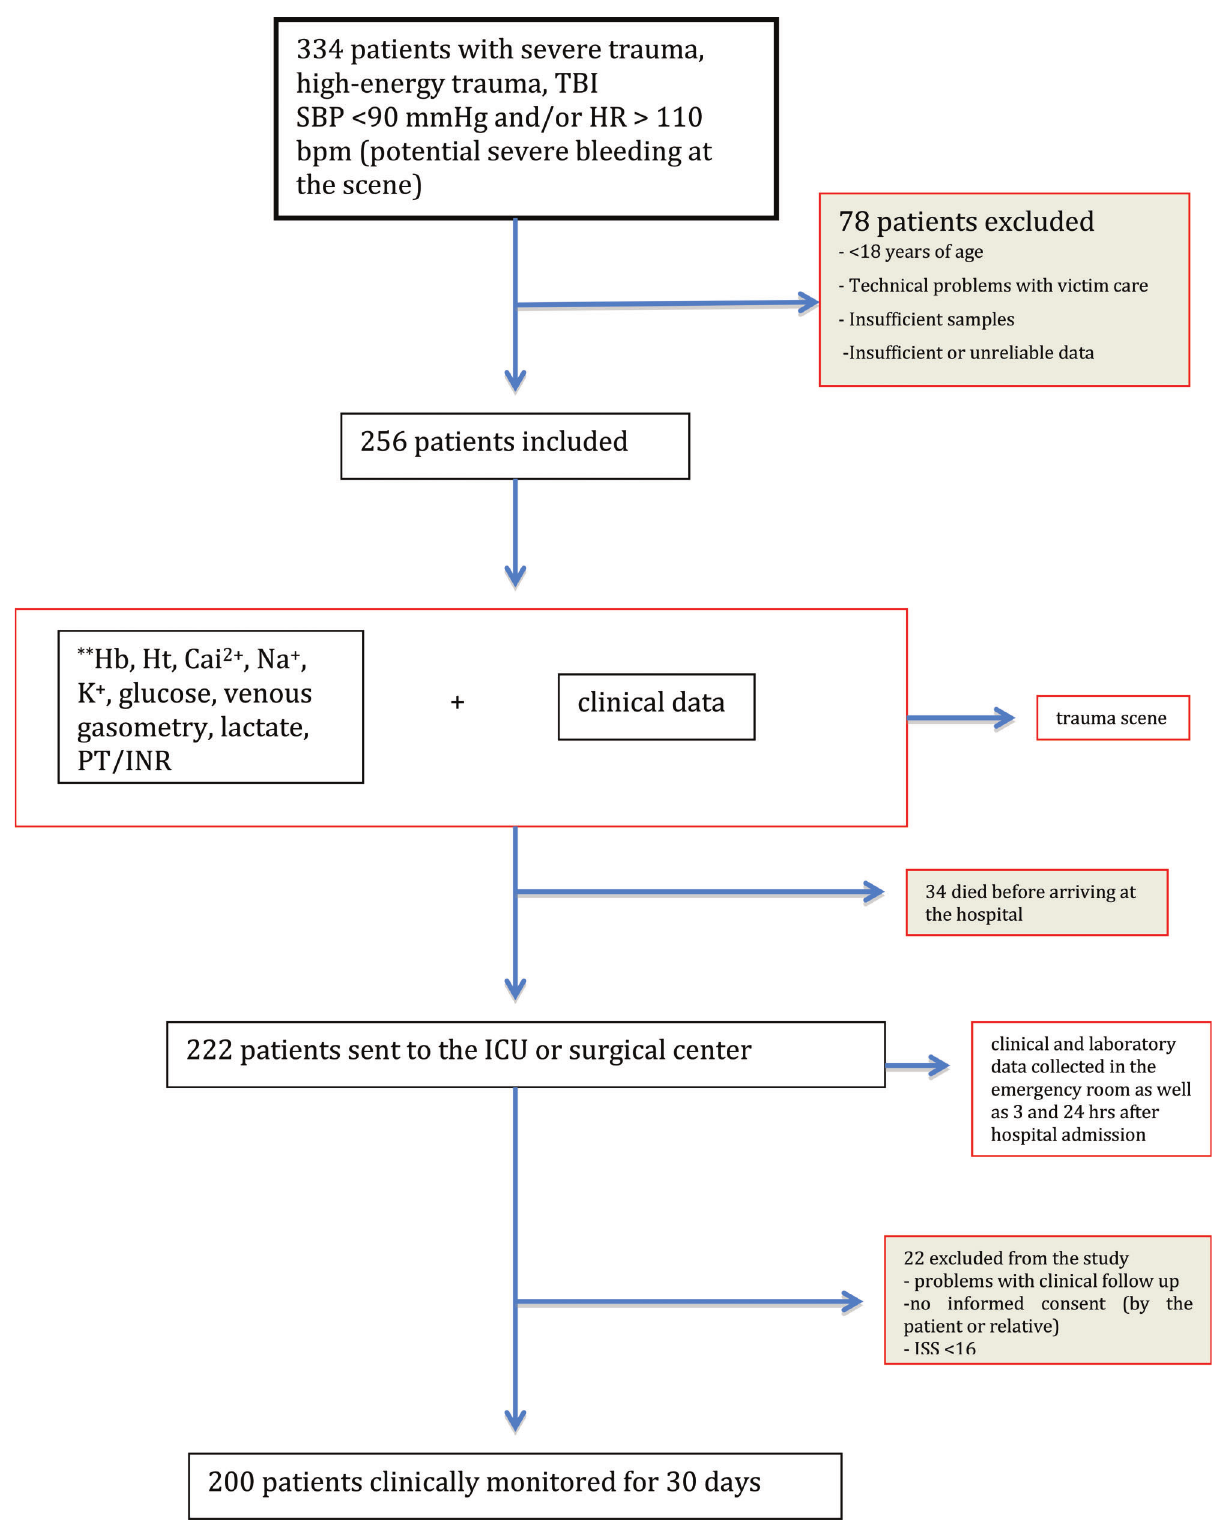
Figure 1 - Flowchart. ISS - injury severity score; SBP - systolic blood pressure; Hb - hemoglobin (g/dL); Ht - hematocrit (%); PT/INR - prothrombin time (s)/international normalized ratio; Ca 2 + - ionized calcium (mmol/L); Na + - sodium (meq/L); K + - potassium (meq/L).